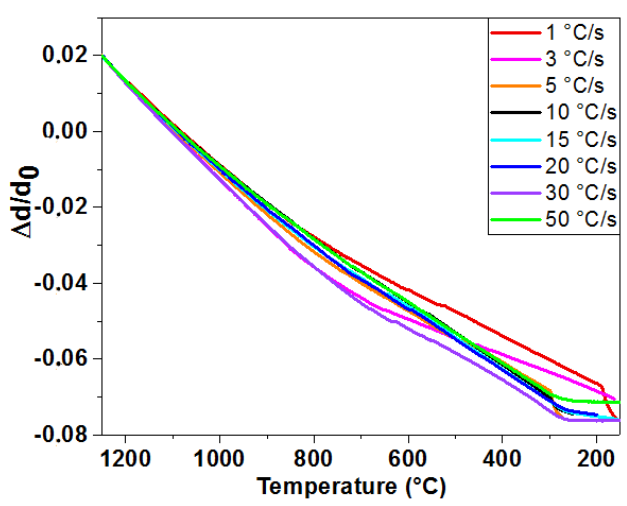
Figure 8. Cooling curves for all samples analyzed in the dilatometry test.